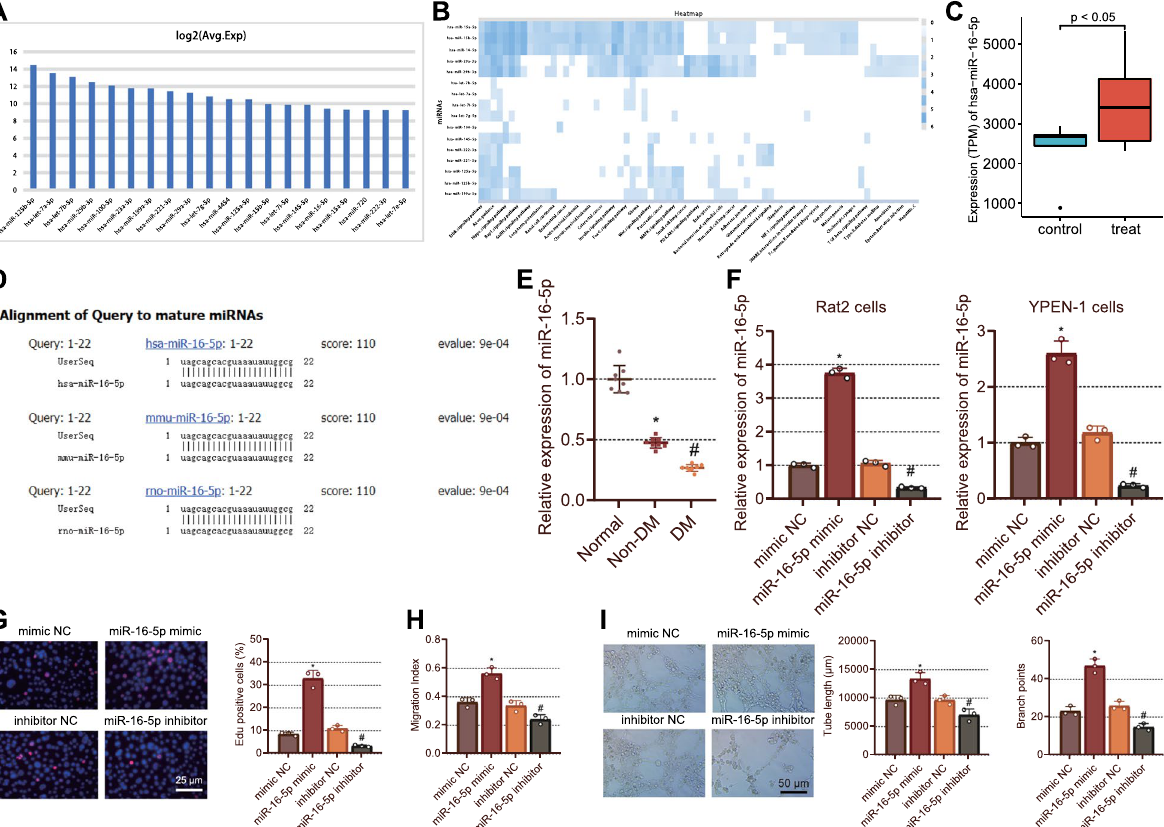
Fig. 1 Promoting effects of miR-16-5p on fibroblast proliferation, migration, and endothelial cell angiogenesis. A The expression patterns of top 20 upregulated miRNAs in DM samples and non-DM samples in the GSE68185 dataset. B KEGG analysis of the candidate miRNAs through miRPathDB, wherein deeper color in blue refers to higher log10 ( p value). C Box plot of miR-16-5p expression in skin wound healing tissues (treat, n 10) − = compared to ulcer skin tissues (control, n 5). D Sequence conservation of miR-16-5p between human, mouse and rat. E RT-qPCR measurement = of the expression of miR-16-5p in the normal foot tissues of normal rats and foot wound tissues of non-DM and DM rats. F Expression of miR-16-5p in Rat2 fibroblasts and YPEN-1 endothelial cells transfected with miR-16-5p mimic or miR-16-5p inhibitor. G The proliferation of fibroblasts transfected with miR-16-5p mimic or miR-16-5p inhibitor determined by EdU assay (red fluorescence: EdU; blue fluorescence: DAPI). H The Rat fibroblast migration transfected with miR-16-5p mimic or miR-16-5p inhibitor determined by scratch test. I Angiogenesis of YPEN-1 endothelial cells transfected with miR-16-5p mimic or miR-16-5p inhibitor detected by vessel-like tube formation assay. In panels F – I : * p < 0.05 vs. cells transfected with mimic NC. # p < 0.05 vs. cells transfected with inhibitor NC. Cell experiments were repeated three times. n 8. Measurement data were = presented as mean standard deviation. Data among multiple groups were compared by one-way ANOVA, followed by Tukey’s post hoc test for ± multiple